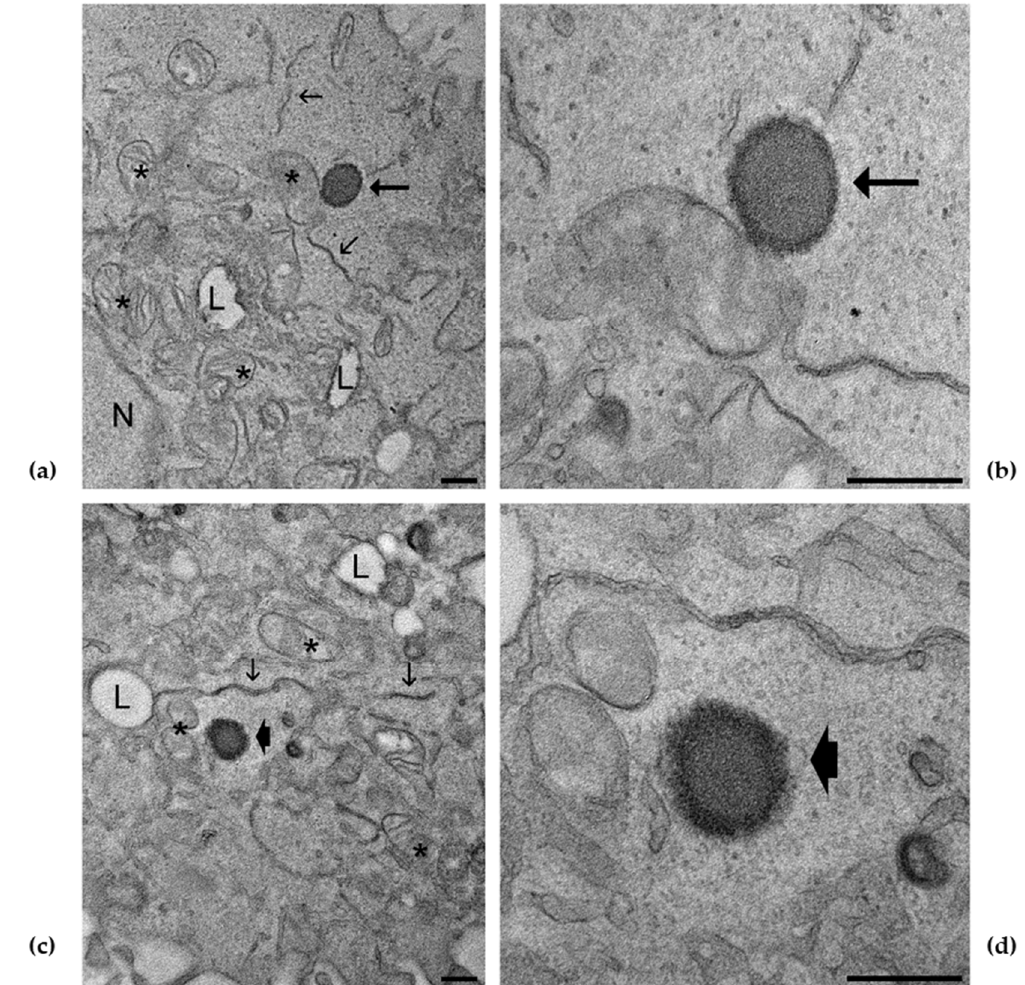
Figure 8. TEM micrographs of keratinocytes treated with E ( a ), high magnification detail in ( b ) and TE5 ( c ), high magnification detail in ( d ). E (arrows) and TE5 (arrowheads) are clearly recognizable in the cytoplasm; note the darker edge likely corresponding to the phospholipid layer. Mitochondria (asterisks), endoplasmic reticulum (thin arrows), lipid droplets (L), nucleus (N). Bars correspond to 200